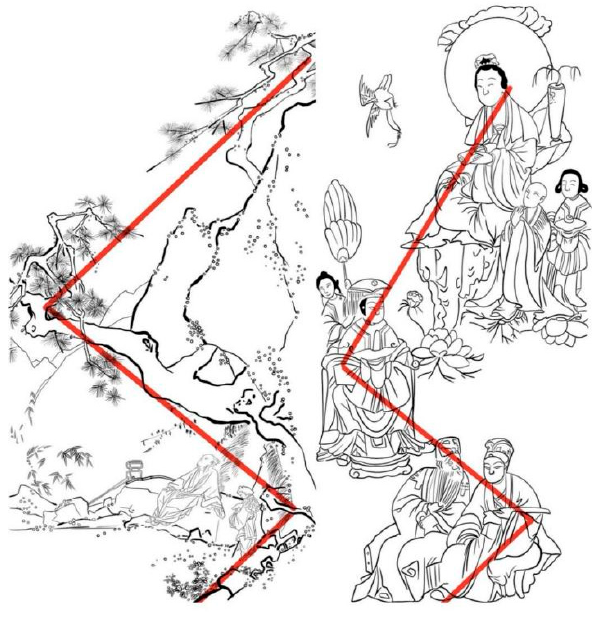
Figure 2. Composition form comparison.